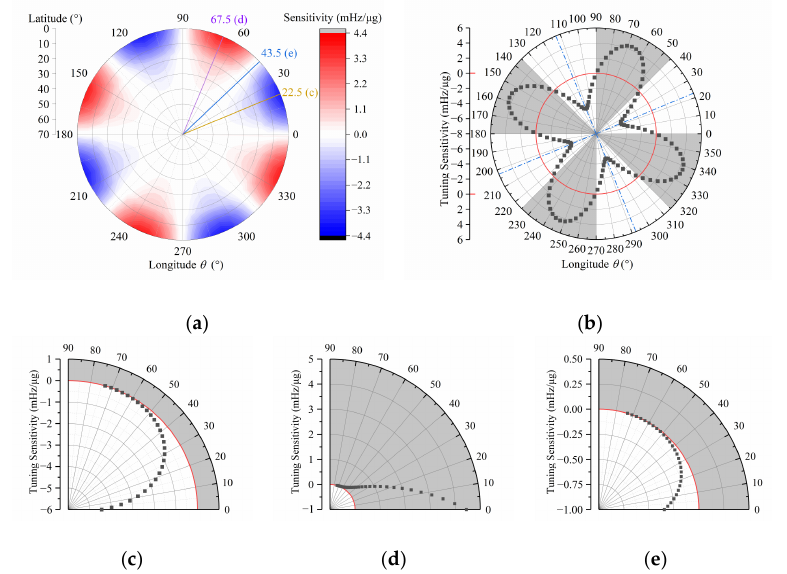
Figure 5. Sensitivity of the frequency split to the material removal amount. ( a ) Tuning on the surface; ( b ) tuning on the lip; ( c ) tuning on the meridian of θ = 22.5°; ( d ) tuning on the meridian of θ = 67.5°; ( e ) tuning on the meridian of θ = 43.5°. The red solid line is the tuning sensitivity of 0, and the blue dashed, dotted line is the location of the lower frequency axis. The gray regions are the non-tuning regions, and the white regions are the tuning regions.